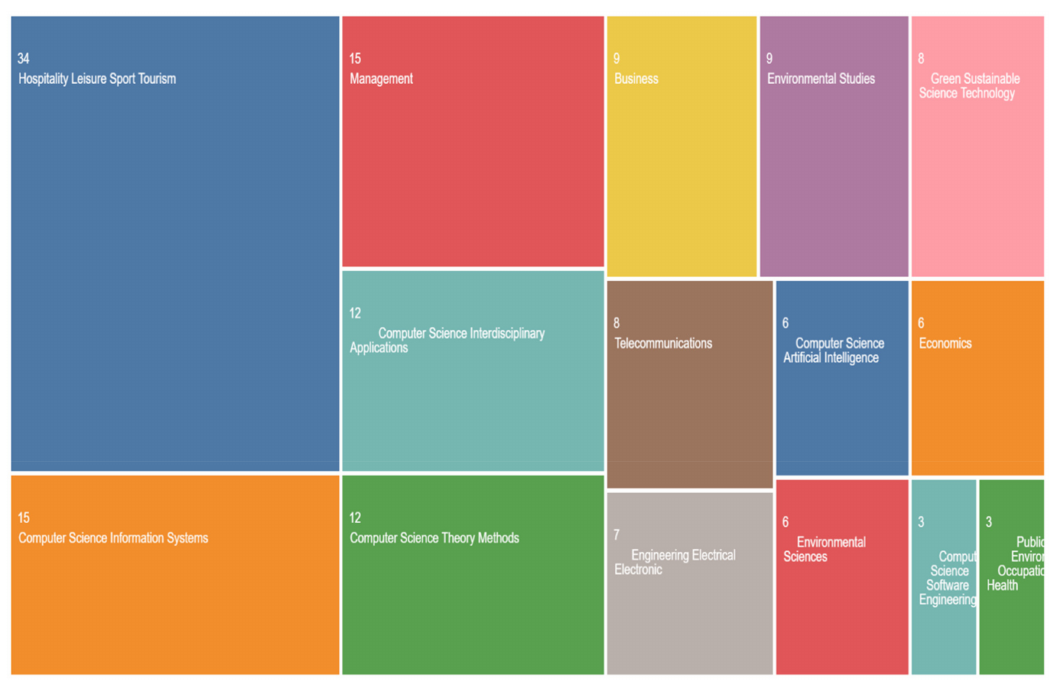
Figure 3. Categories of publications filtered and considered for the study. Source: Web of